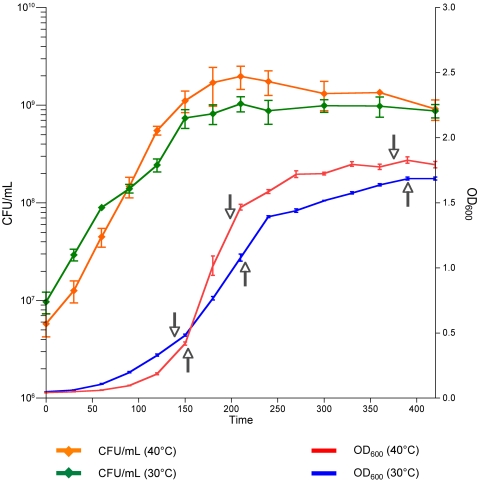
Growth curves for GBS strain NEM316 at different temperatures.Overnight THY cultures were diluted 1:50 with fresh THY broth at 30°C or 40°C and cultured in 5% CO2. Growth was monitored by measuring the OD600 and CFU counts with blood agar plates.